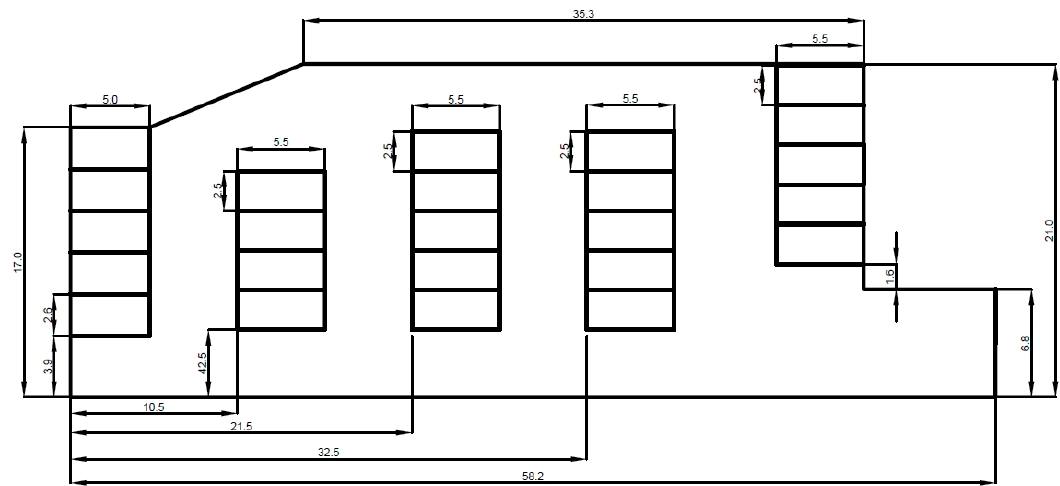
Figure 3. Layout of the parking lot (distance unit in meter).